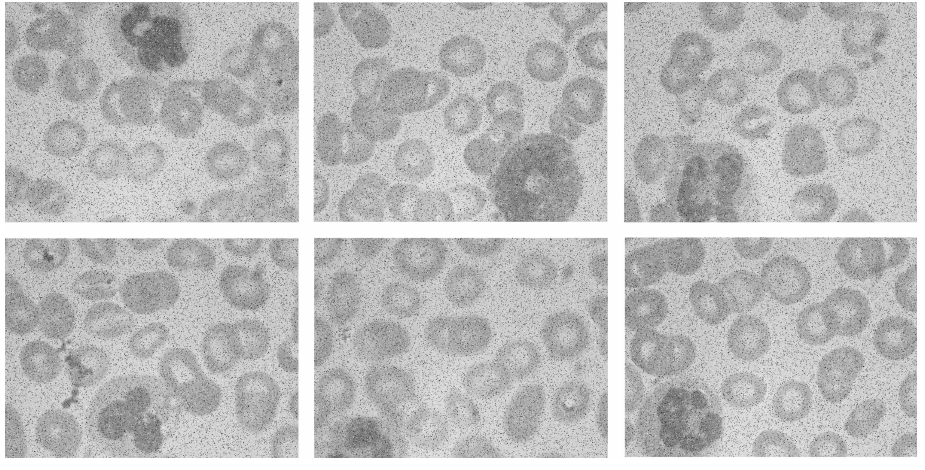
Figure 19. Some images from the blood cell image dataset.